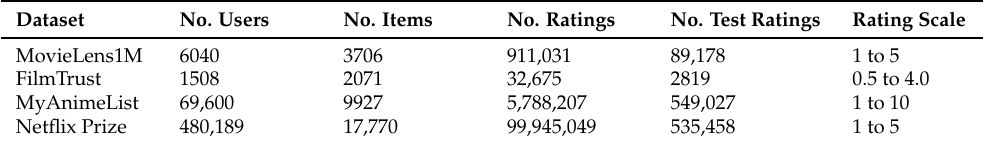
Table 5. Datasets used in the